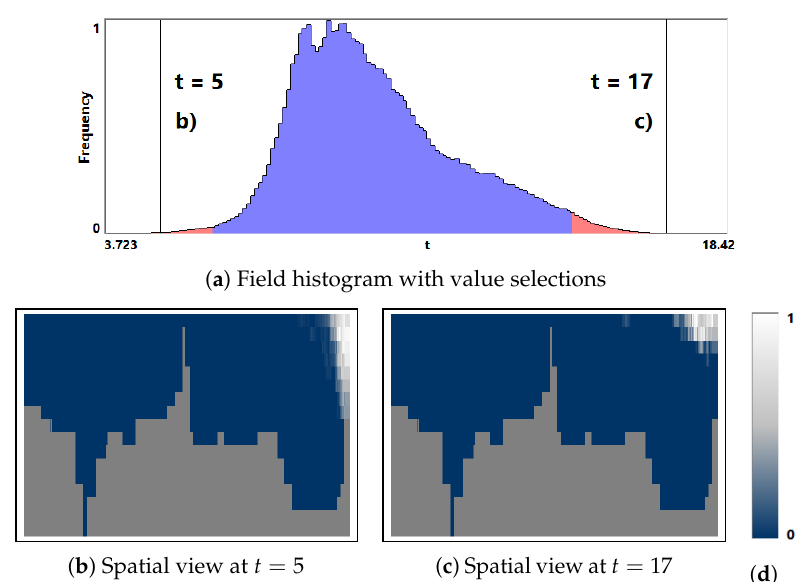
Figure 20. ( a ) Field distribution histogram for water temperature t in the local climate simulation. ( b , c ) Linked visualizations of the spatial distribution of appearance for the selected temperatures in ( a ) using transfer function ( d ).